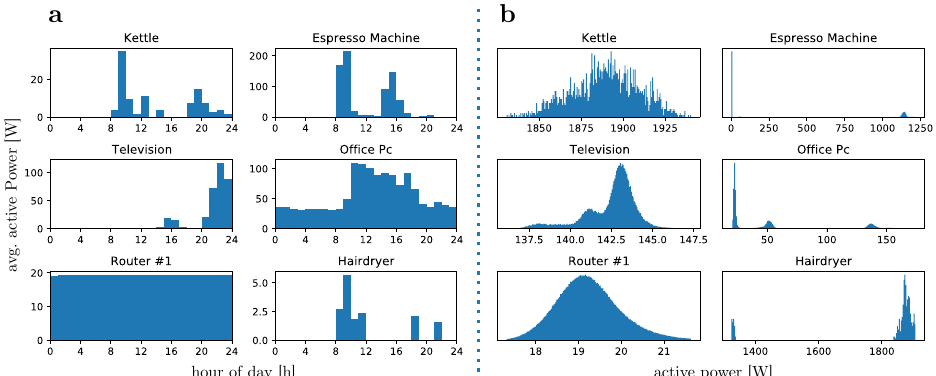
Figure 12. Appliance usage over the complete recording duration. ( a ) shows the daily usage patterns of the devices as the average power for each hour-of-day; ( b ) shows the histogram of the power demands. A 2W threshold was set to omit data in which no power is